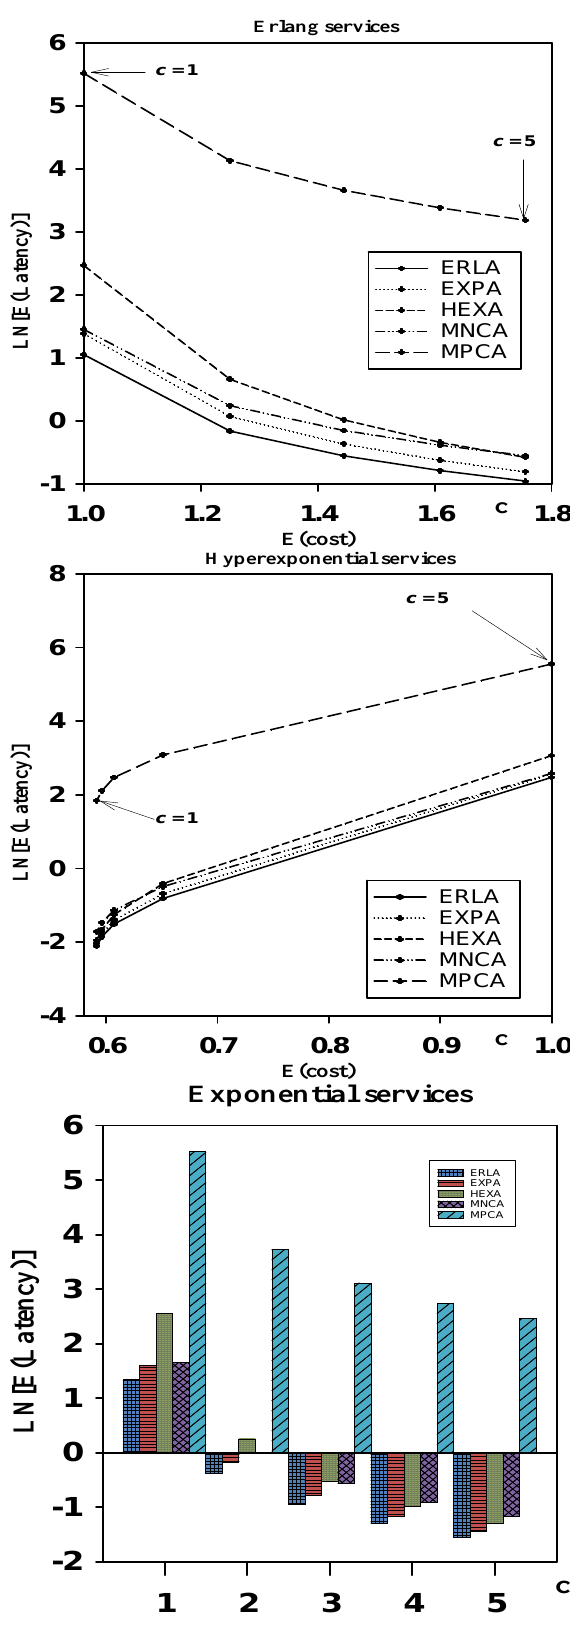
Figure 2: ln ( E ( L )) vs E ( C ) as c is varied under different